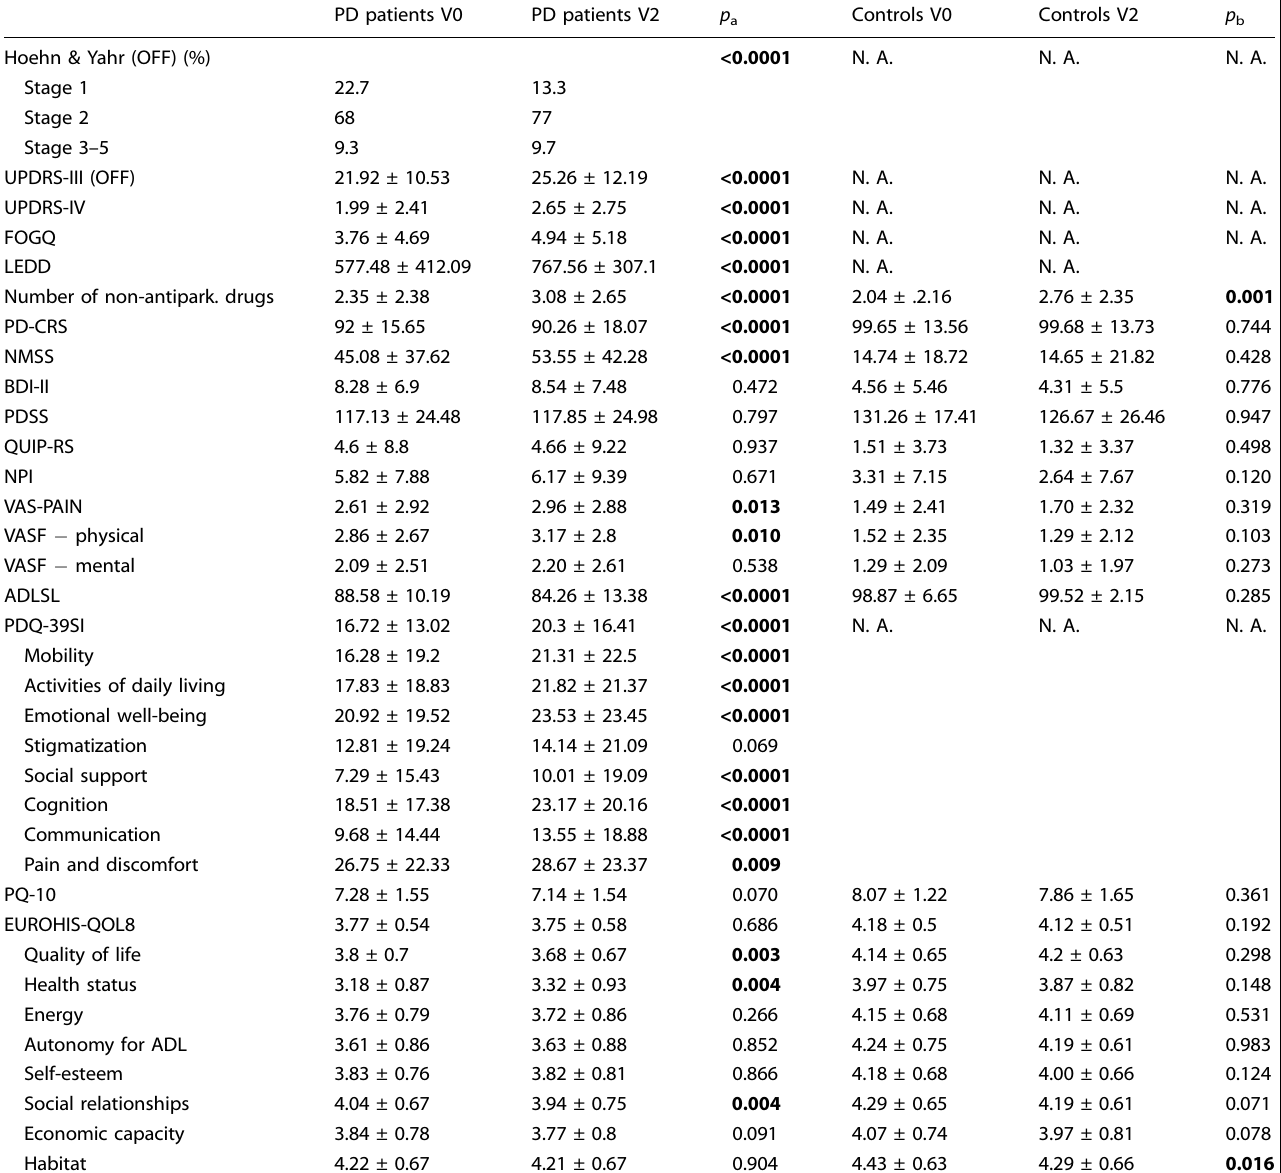
Table 1. Changes in motor and non-motor symptoms, disability, and quality of life in PD patients and/or controls from V0 (baseline) to V2 (2 years ± 1